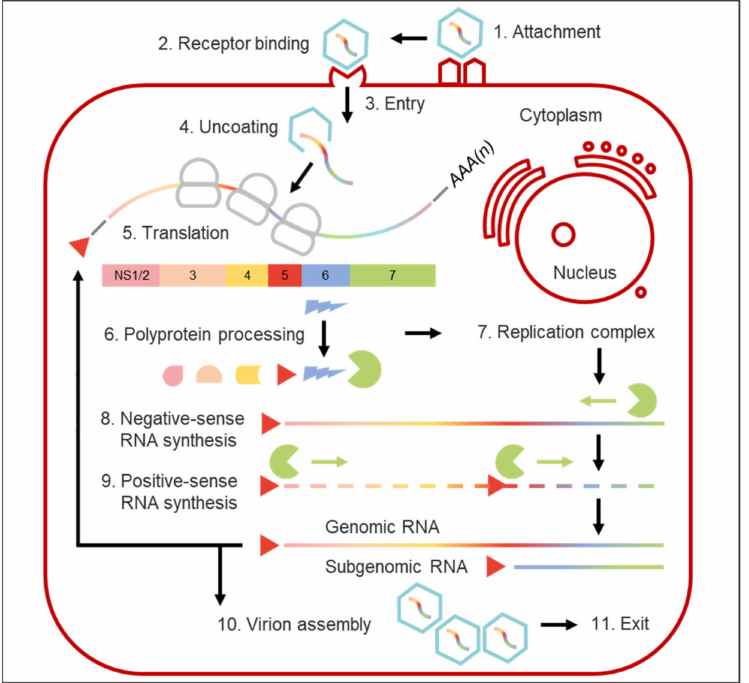
Figure 3. Outline of the norovirus replication cycle. Human and murine noroviruses (turquoise hexagons) attach to the cell surface using carbohydrate attachment factors and cofactors ( 1 ). To mediate entry, binding to a protein receptor is required ( 2 ). After entry ( 3 ) and uncoating ( 4 ), the incoming viral genome is translated through interactions with genome-linked protein VPg (nonstructural protein NS5, red triangle) at the 5 (cid:48) end of the genome and the cellular translation machinery ( 5 ). The open-reading frame 1 polyprotein is co- and post-translationally cleaved by the viral protease (NS6, blue flash) ( 6 ). The replication complex is formed by recruitment of cellular membranes to the perinuclear region of the cell, through interactions with NS1/2 (rose shape) and NS4 (yellow shape) ( 7 ). Genome replication occurs via a negative-strand intermediate (dashed line) ( 8 ), and genomic and subgenomic RNA (unbroken lines) are generated by the viral RNA-dependent RNA polymerase (NS7, green jagged circle), using de novo and VPg- or internal promoter-dependent mechanisms ( 9 ). Replicated genomes are translated or packaged into the capsid (in the case of whole-length genomes), composed mainly of viral protein 1 (VP1), for virion assembly ( 10 ) and exit ( 11